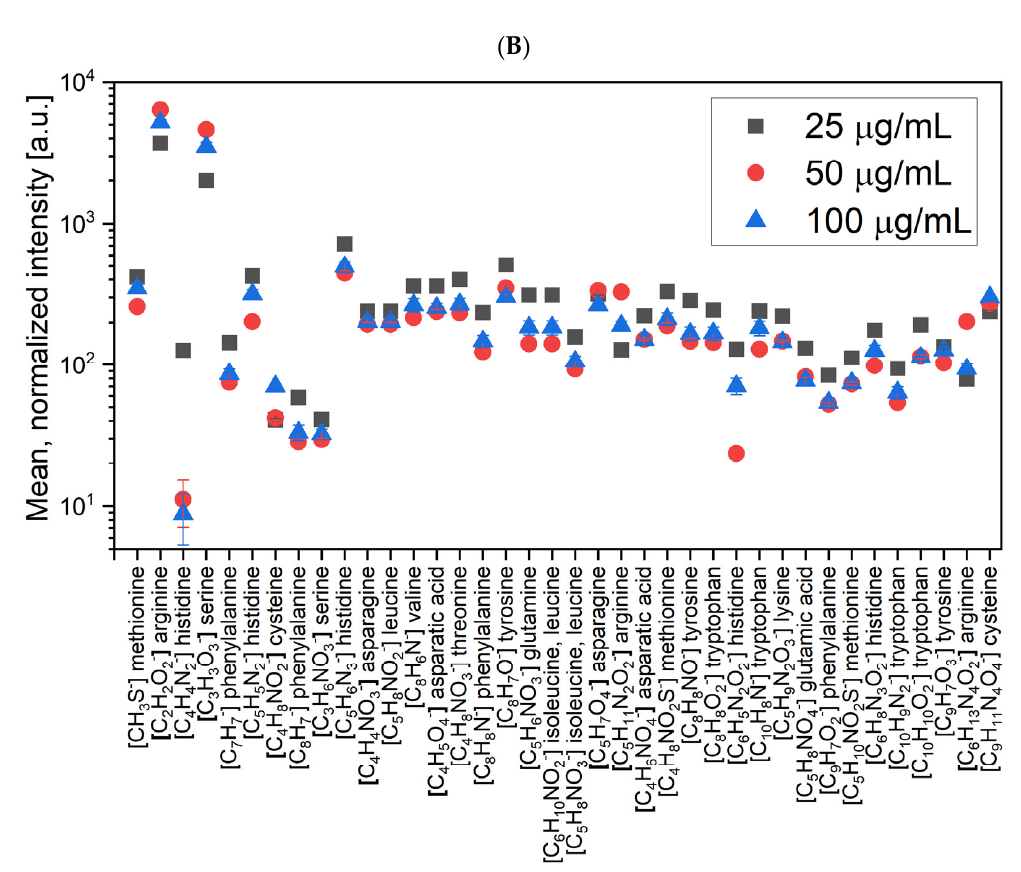
Figure 5. Values of the mean normalized intensities for the characteristic amino acid peaks in ( A ) positive and ( B ) negative ions for the three concentrations of LACT deposited on the surface of functionalized silicon with APTES and GA.